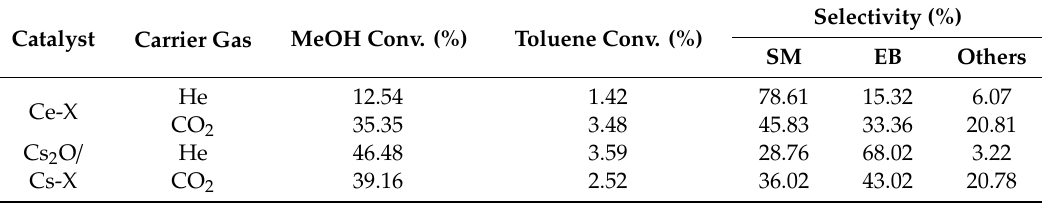
Table 10. Performance of CO 2 in the toluene side-chain alkylation (Reproduced with permission from [91]; copyright (2018), Elsevier).